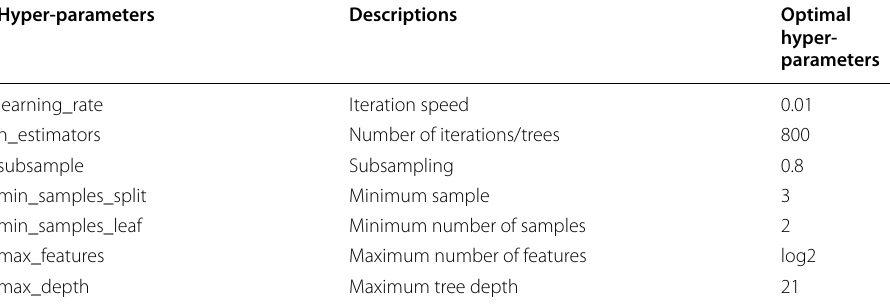
Table 3 Parameters specified in the model Hyper-parameters